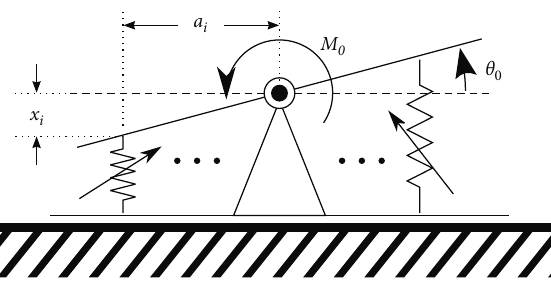
Figure 9: Moment and associated angle of the planar isolation